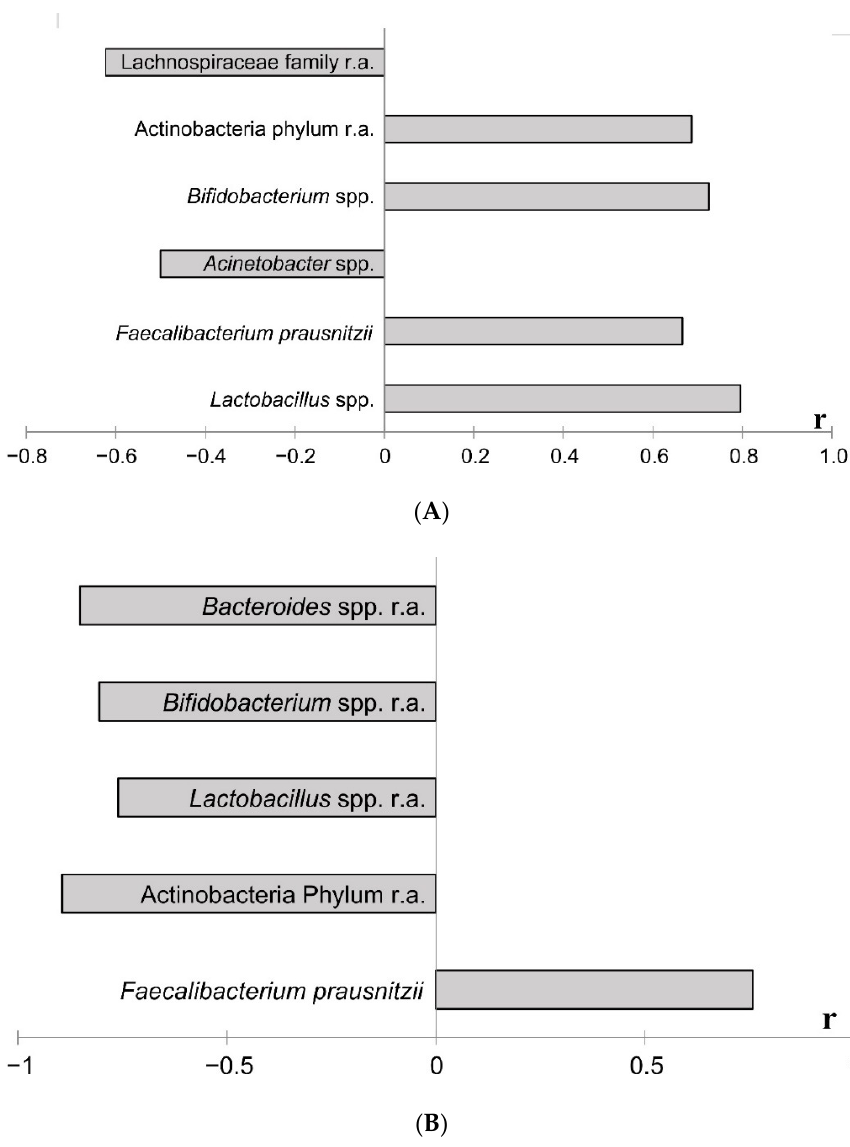
Figure 9. Coefficients of correlation by analysis between the relative abundance/quantitative content of Akkermansia spp. ( A ) or Roseburia spp. ( B ) and other taxa in the intestinal microbiota at the end of the experiment. Notes: total data for all animals, the results of the study are presented using p < 0.05. A search for correlations between the studied parameters was performed using Spearman’s test. r.a.—relative abundance. The quantitative content of taxa was analyzed in other causes. At the same time, a negative correlation relationship between Acinetobacter spp.